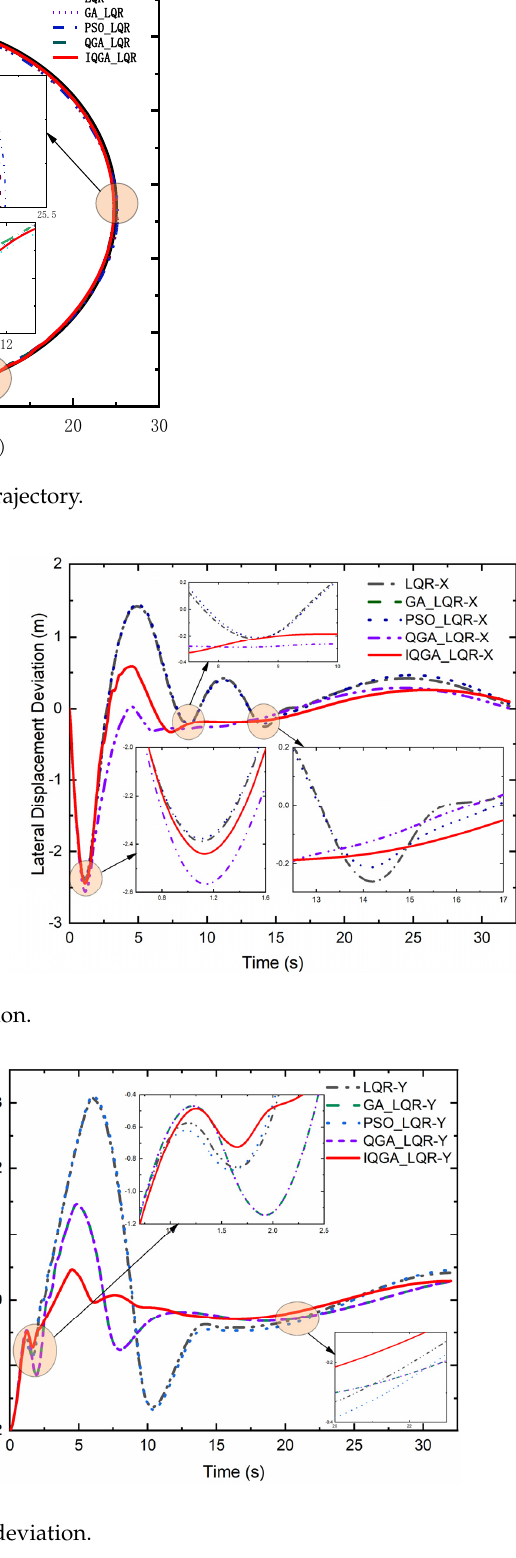
Figure 6. Longitudinal displacement and deviation.